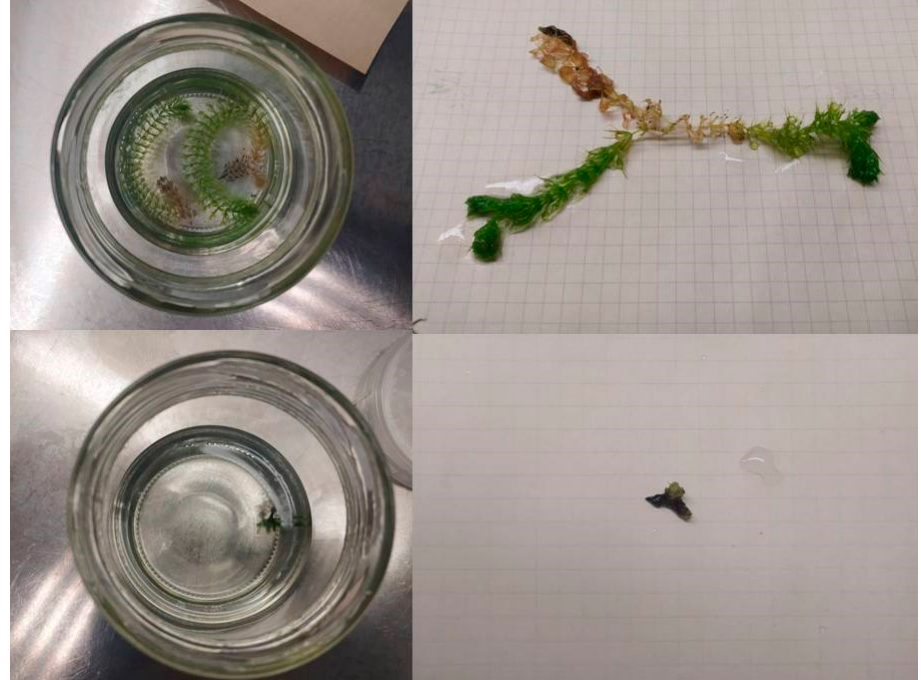
Figure 3. Subsequent influence of the AgNPs 1/5 MS media supplementation on the Aldrovanda vesiculosa morphological features of shoots after the first 8-week passage in the AgNPs-free media.